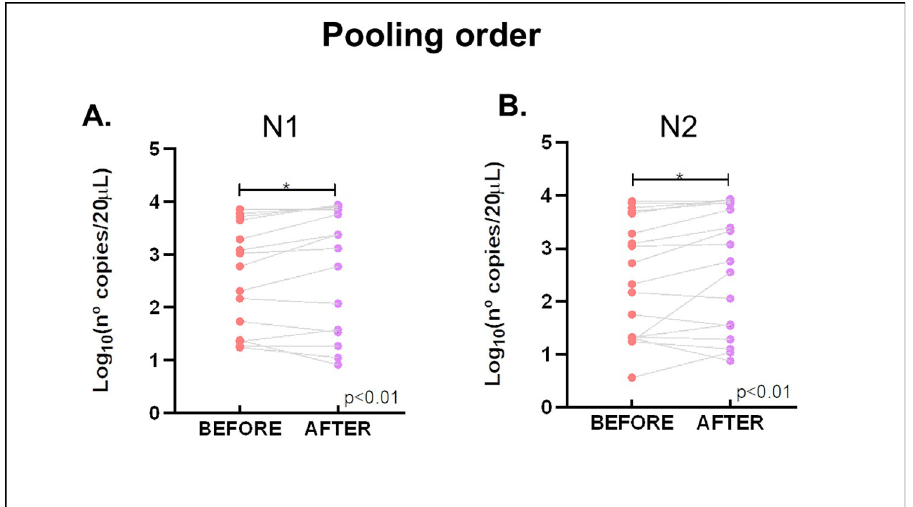
Fig 1. Pooling order assay. N˚ copies/20 μ L were obtained by pooling before or after extraction for A) N1 and B) N2 sequences of the N gene of SARS-CoV-2. The Wilcoxon test and Friedman’s tests for paired, non-parametric samples determined that there is a significant difference (p < 0.01) between both pooling ways.